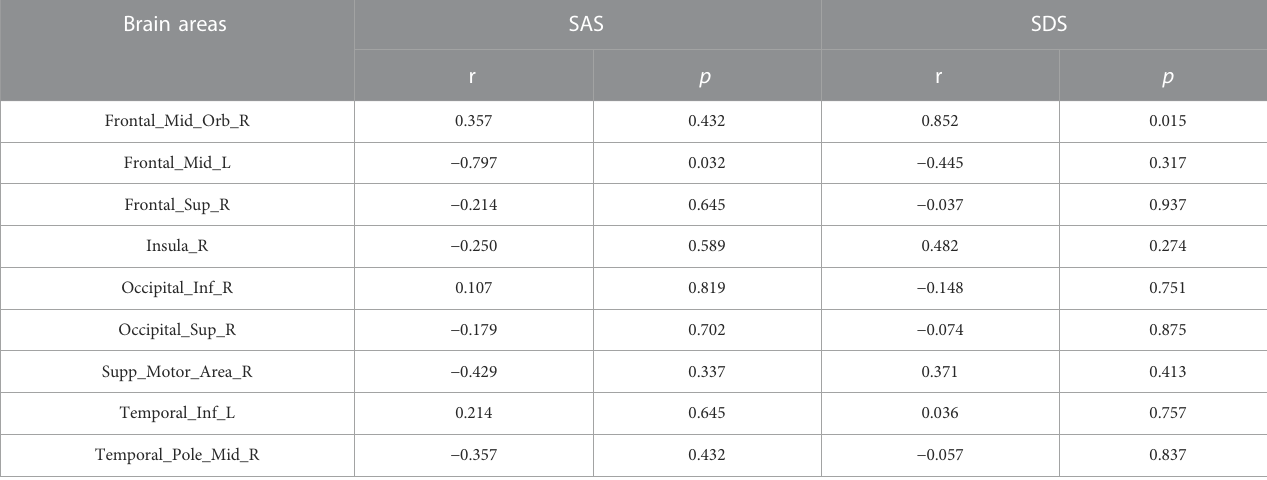
TABLE 5 Correlation between SAS-SDS and local brain activity after intervention. Brain areas